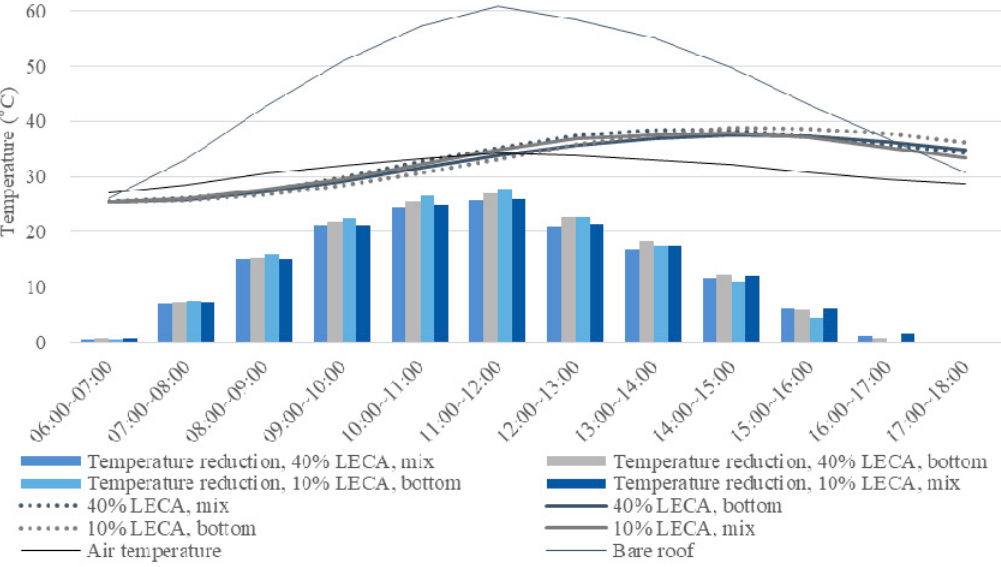
Figure 18. Temperatures and temperature reductions in the cases of the roofs with 10% and 40% LECA laid at the bottom with Ipomoea batatas , and of 10% and 40% LECA mixed with the soil with Ipomoea batatas (1 October 2017 06:07:57–1 October 2017 17:57:57).